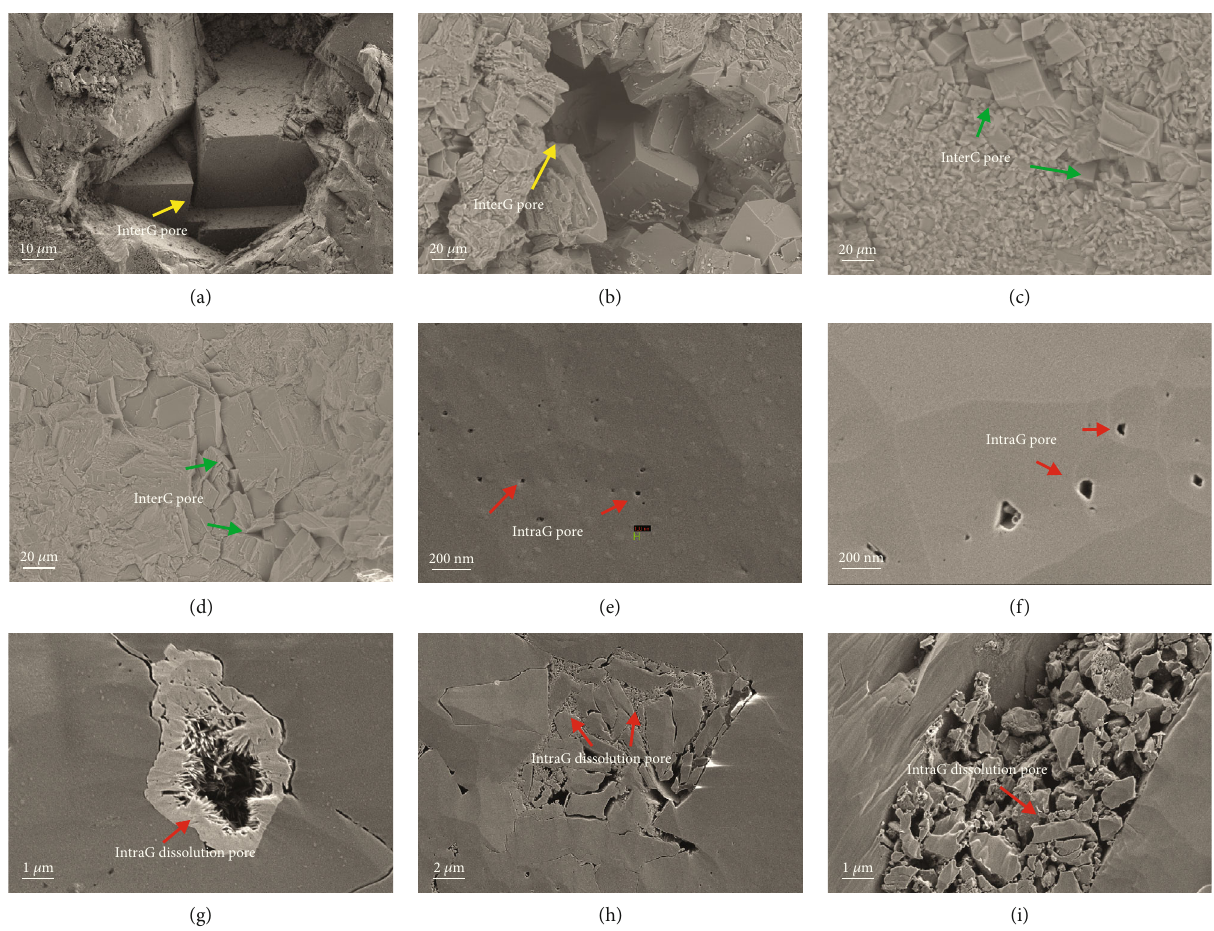
Figure 4: Typical FE-SEM images of pores in dolomites from the Xiaoerbulake Formation: (a) intergranular pores (SE mode); (b) intergranular pores (BSE mode); (c, d) intercrystalline pores (BSE mode); (e, f) intragranular pores (SE mode); (g – i) intragranular dissolution pores (SE